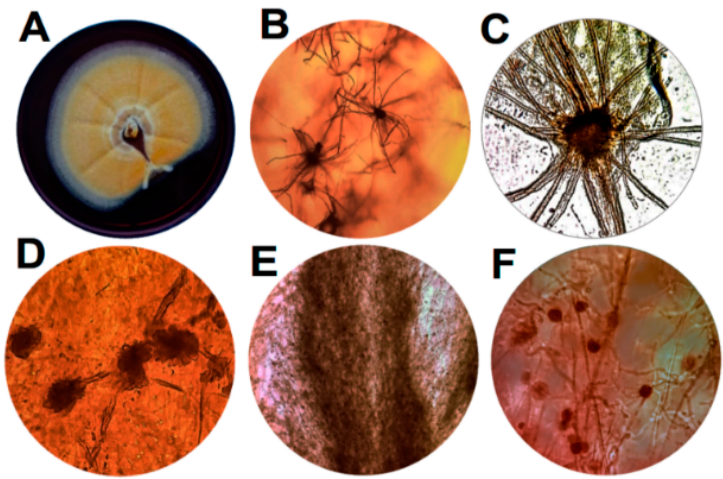
Figure 1. Morphological features of Arcopilus aureus MaC7A. ( A ) A. aureus in PDA medium. ( B ) The presence of globular/ellipsoid ascomata. ( C ) Ascomata showing lateral hyaline hyphae. ( D ) Terminal brown hyphae showing a coiled shape. ( E ) Vegetative mycelium. ( F ) Somas showing tabicated and hyaline hyphae.